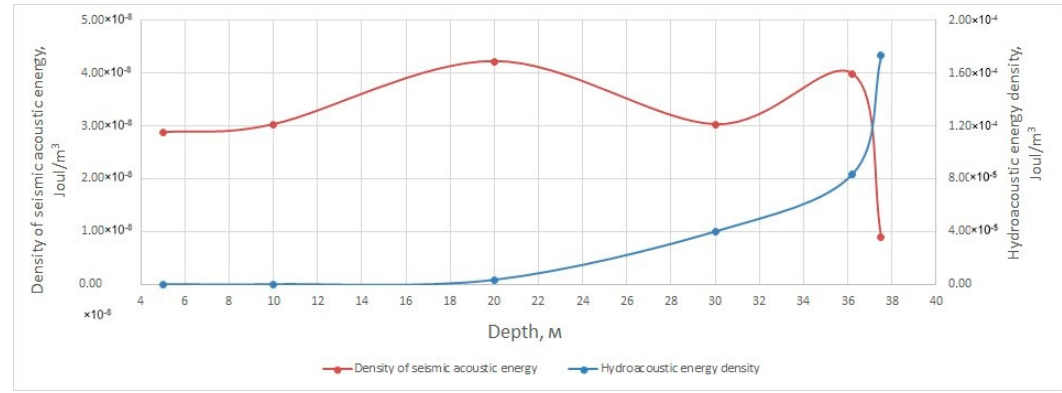
Figure 8. Graphs of the dependence of the seismoacoustic and hydroacoustic wave energy densities on the depth of the points where the measurements were taken. the depth of the points where the measurements were taken.